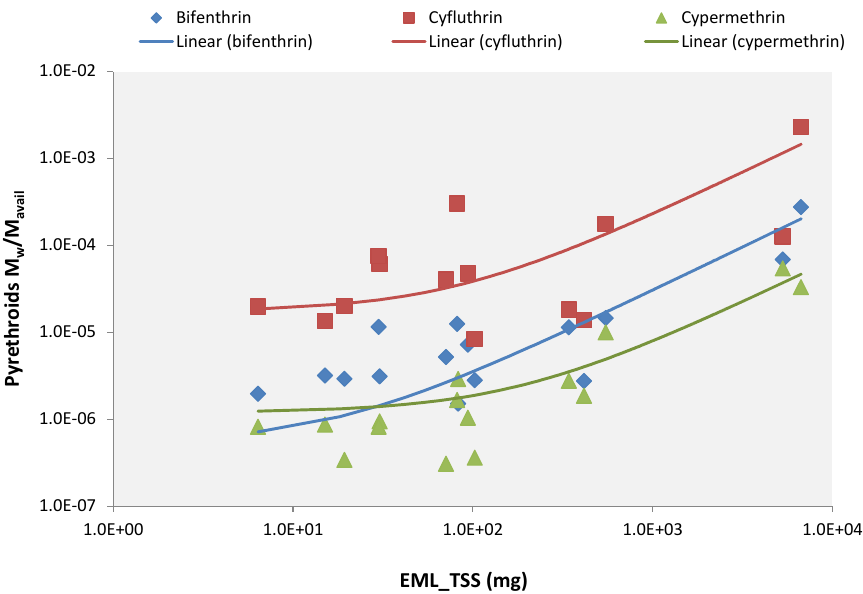
Figure 4. Linear correlation between total suspended solid (TSS) event mean load (EML) and the fraction of insecticide load washed off and mass available to be washed off.